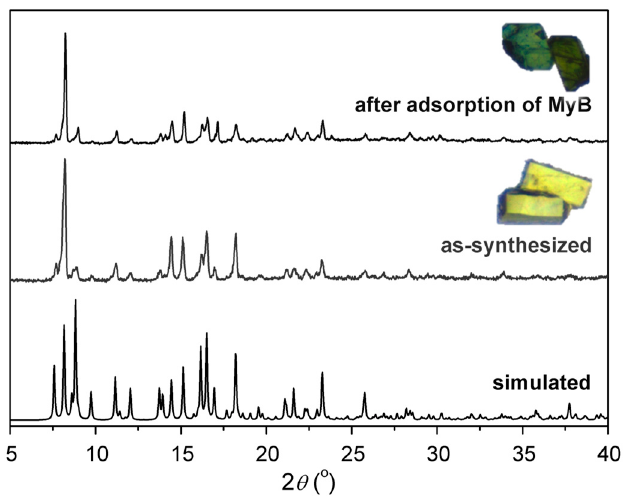
Figure 1. X-ray powder diffraction (XRPD) patterns of 1 . The crystal photos represent the crystals of 1 before and after adsorption of methyl blue (MyB).